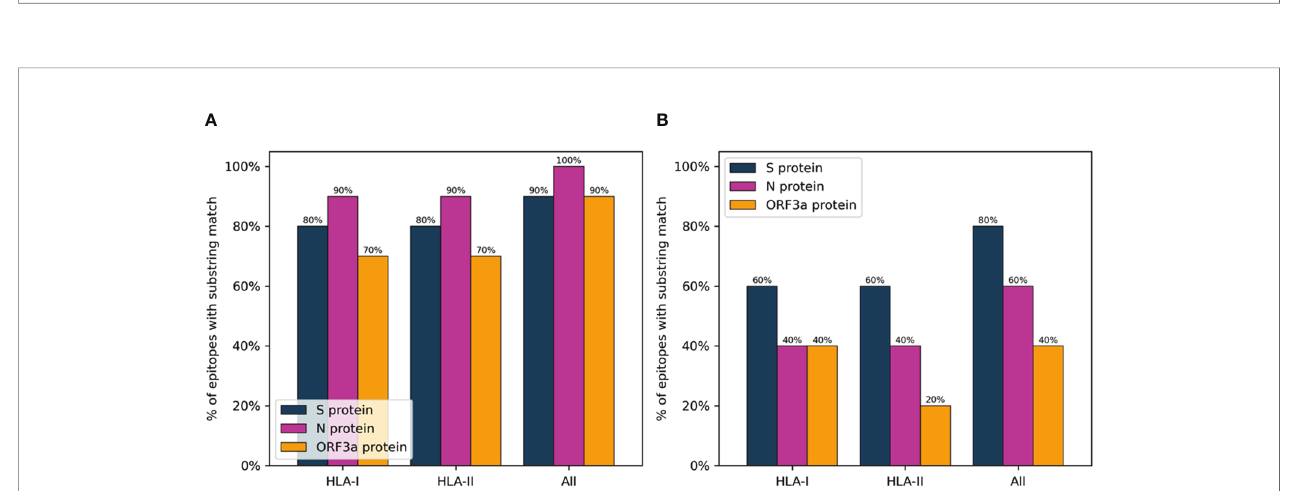
FIGURE 7 | Percentage of peptides selected by the PopCover (A) and Random (B) methods with substring match to IEDB SARS-CoV-2 epitopes. HLA-I: Percent overlap calculated on HLA-I epitopes, with a substring length of 8 or more amino acids. HLA-II: Percent overlap calculated on HLA-II epitopes, with a substring length of 9 or more amino acids. All: Percent overlap calculated on the combined set of HLA-I and HLA-II epitopes, with minimum substring lengths of 8 and 9 amino acids for HLA-I and HLA-II epitopes, respectively.